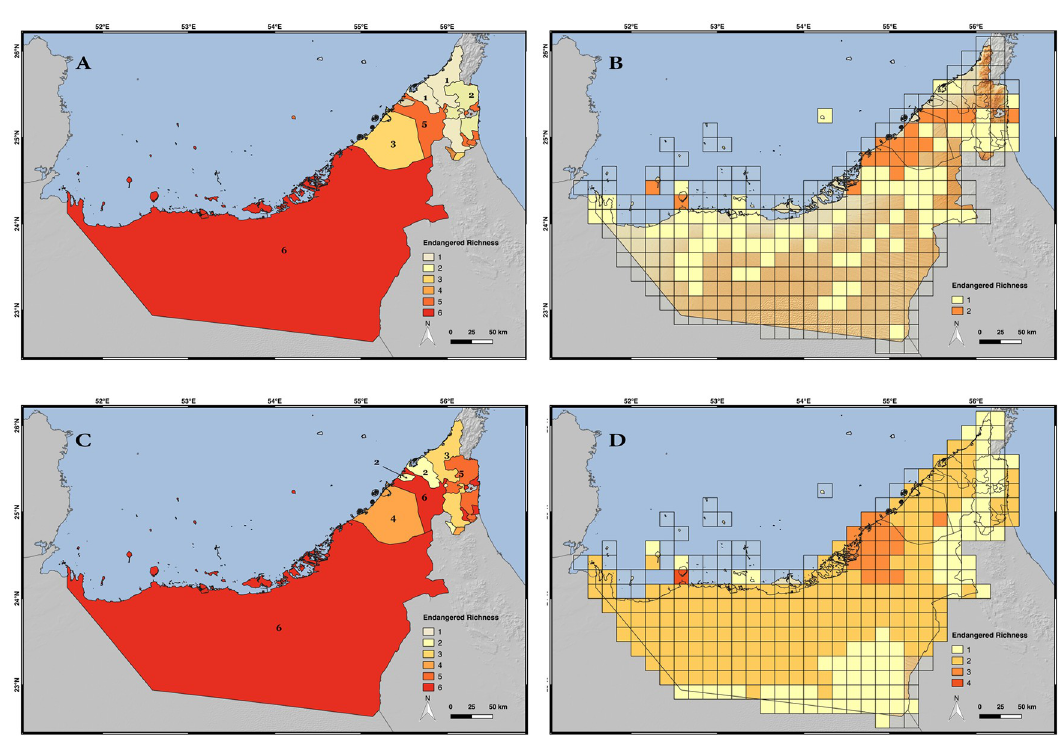
Fig 7. Threatened species richness map of the UAE terrestrial reptiles. A) Threatened species richness by emirate inferred with the occurrence point data; B) Threatened species richness by 10 arc-minutes grid cells inferred with the occurrence point data;